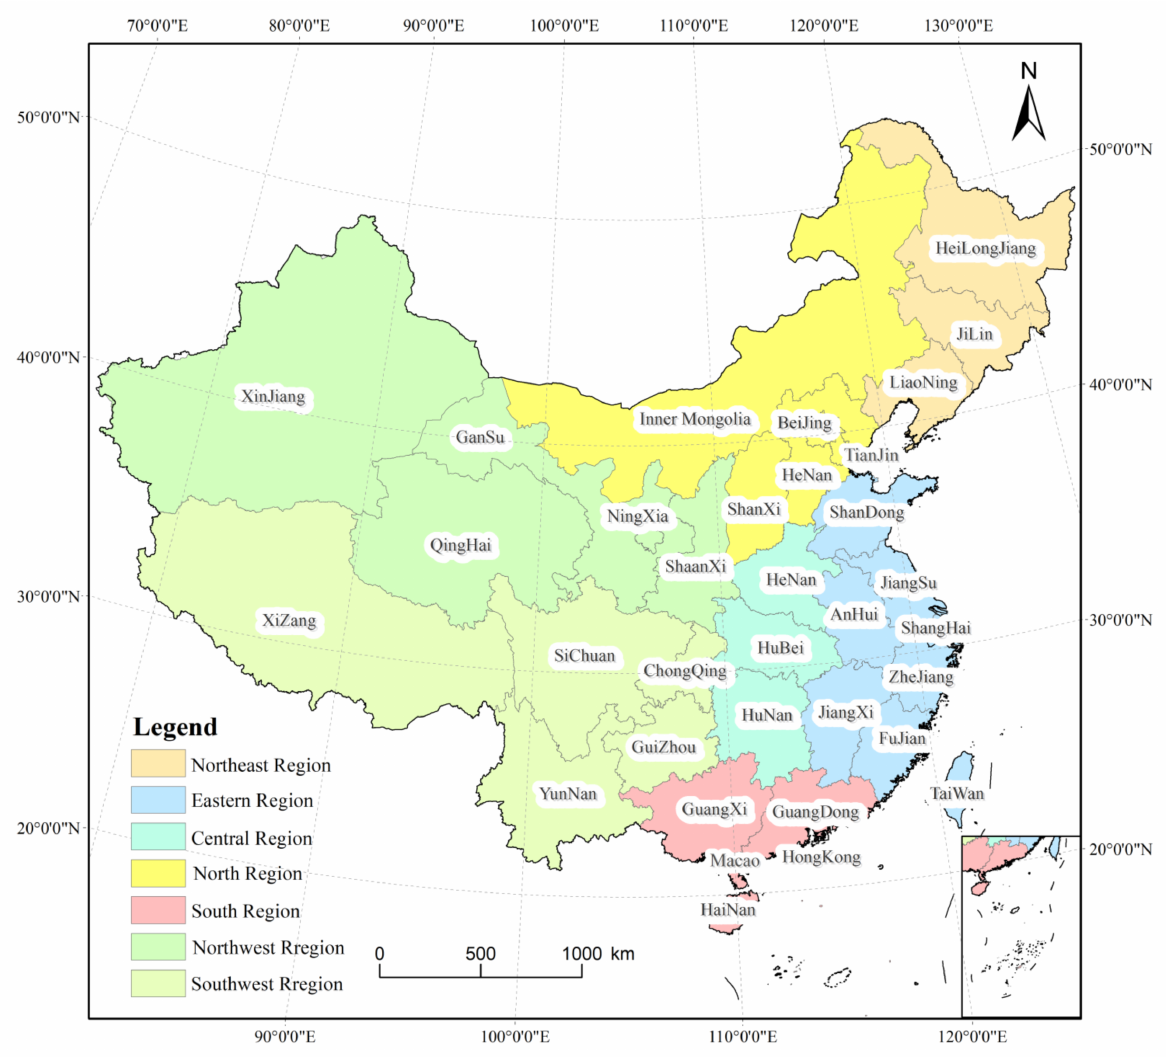
Figure 2. Administrative Zoning Map of